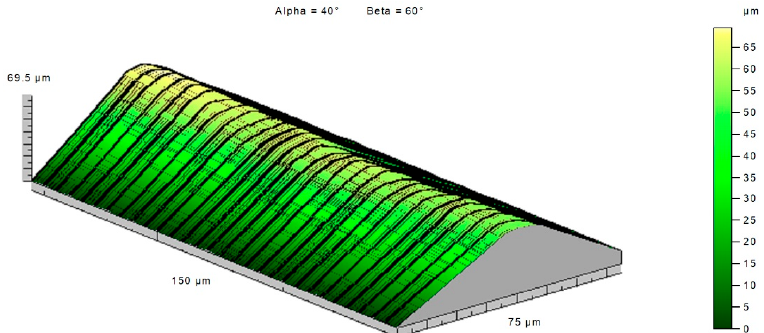
Figure 24. Cutting edge radius r n of the worn cutting insert after longitudinal turning without cool- ant (36 HRC).